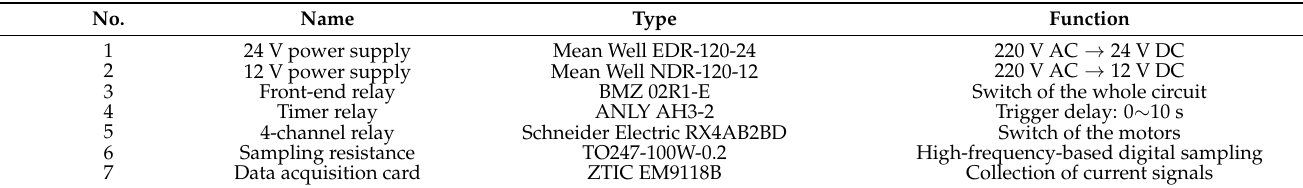
Table 3. Type and function of the apparatuses in the control cabinet.